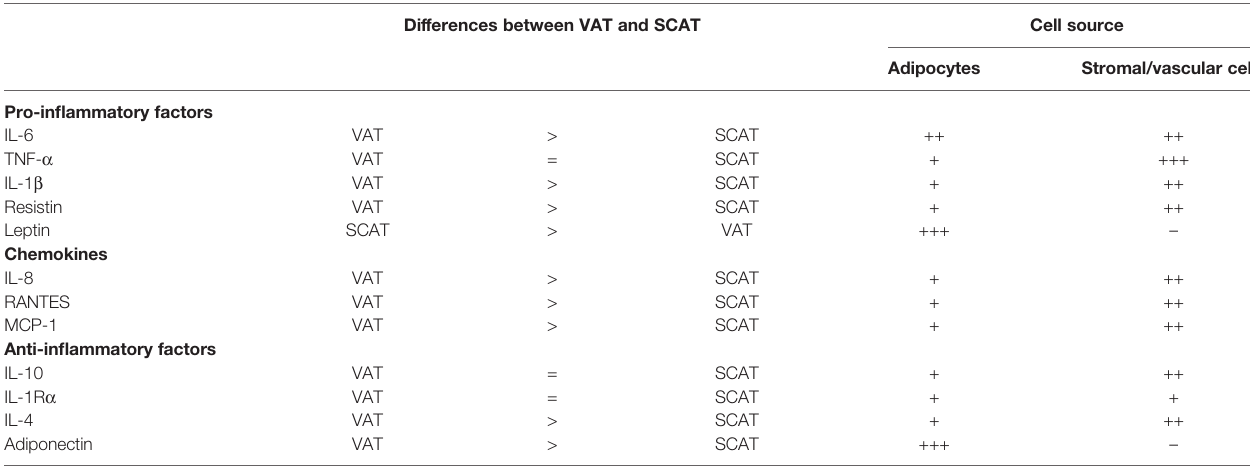
TABLE 1 | Cytokine production by